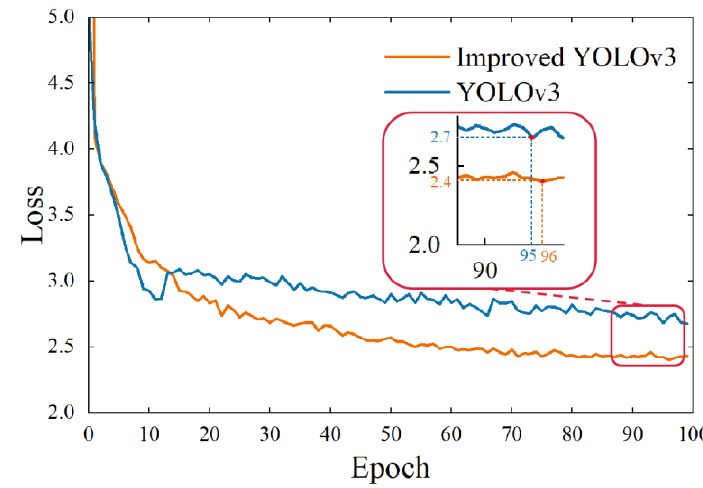
11 of 21 Table 1. Experimental configuration and parameters. Configuration